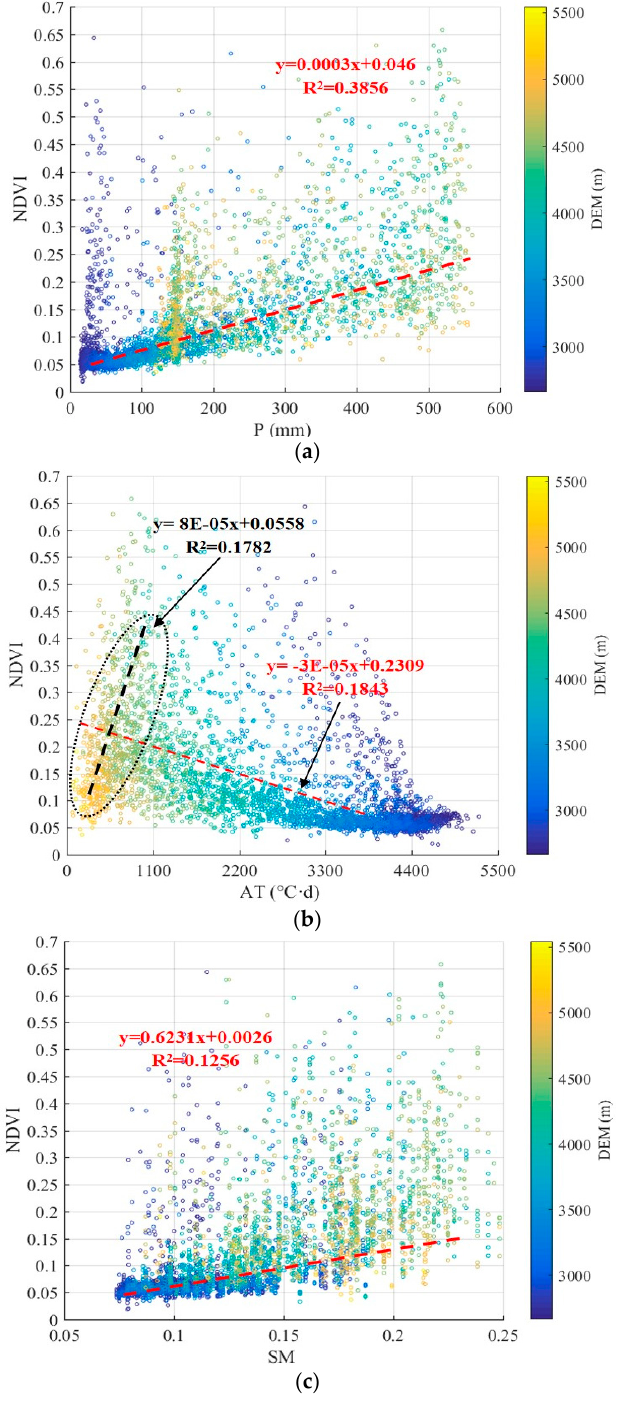
Figure 9. The relationship among NDVI, DEM and AT ( a ), precipitation ( b ) and SM ( c ).